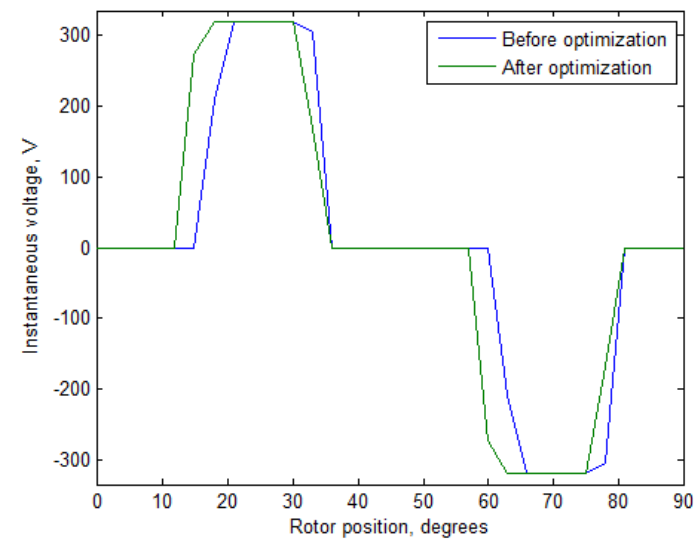
Figure 6. Voltage dependencies on the rotor position before and after optimization.